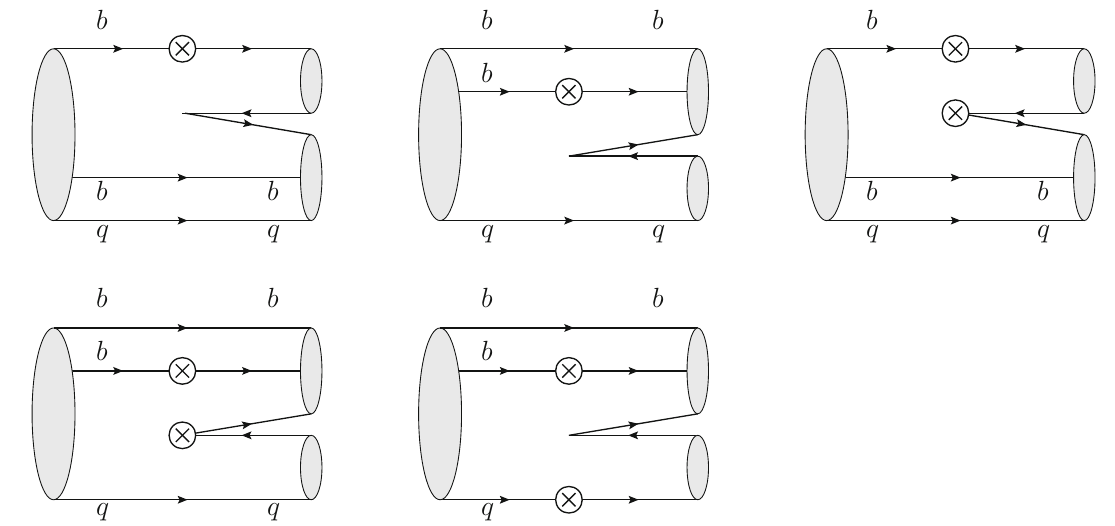
Fig. 11 The Feynman diagrams for (cid:2) bb and (cid:5) bb decays into a bottom baryon and a light meson Table 17 Doubly bottom baryons decays into a bqq and a light meson induced by the charmless b → d transition